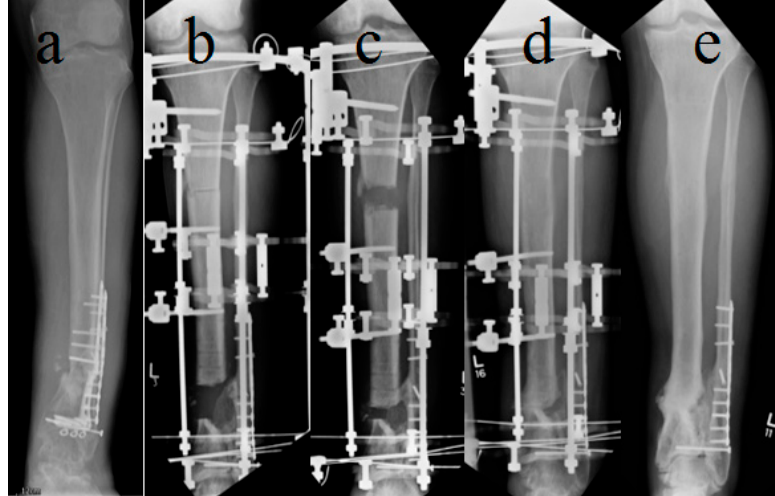
Figure 2. Bone Transport. ( a ) Previous open fracture of distal tibia, treated with internal fixation. The wound broke down and he was referred with a mobile infected non-union. Preoperative AP x-ray shows that the lateral tibial plate has broken at the non-union. ( b ) Four centimetre resection of the non-union after removal of the infected tibial plate. The fibula was intact and well aligned, so a bone transport was preferred. ( c ) Twenty-six days after surgery. The proximal corticotomy is distracted at 1 mm per day. ( d ) Six weeks after docking. No surgery was required to secure union at the docking site. ( e ) Four months after frame removal with well consolidated docking site, regenerate and good alignment.